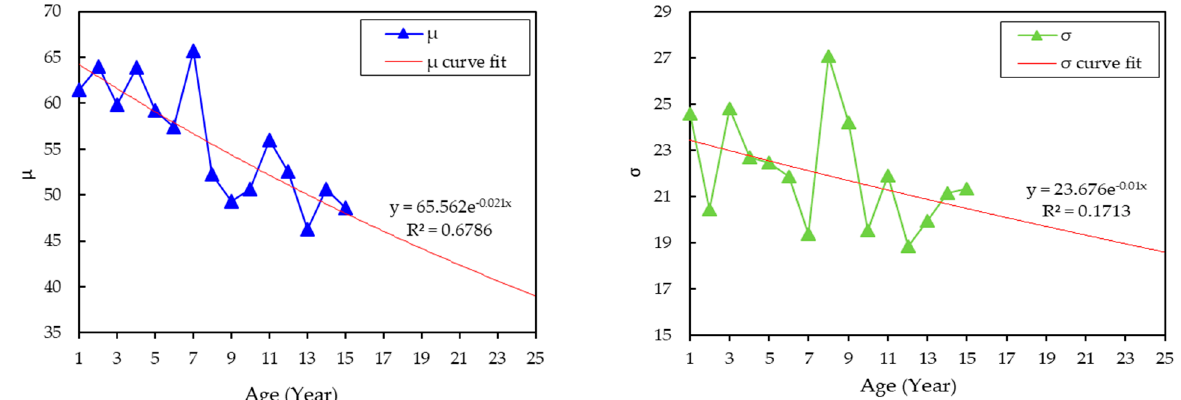
Figure 4. Parameters estimation for dielectric breakdown voltage based on the normal distribution model.